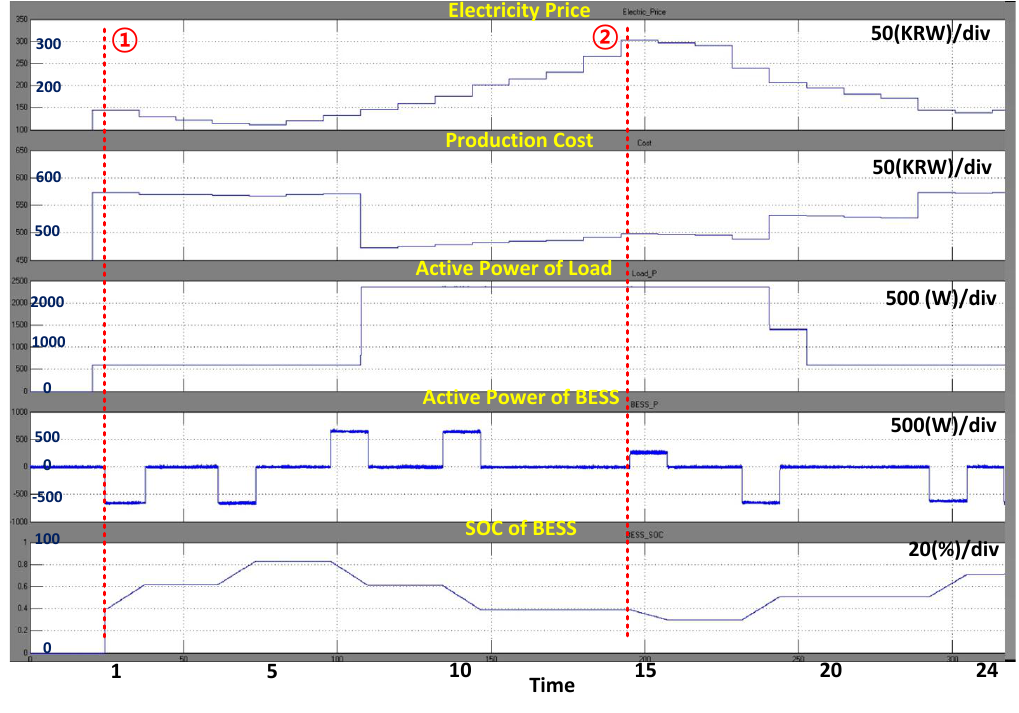
Figure 9. HILS test result of scenario 1.